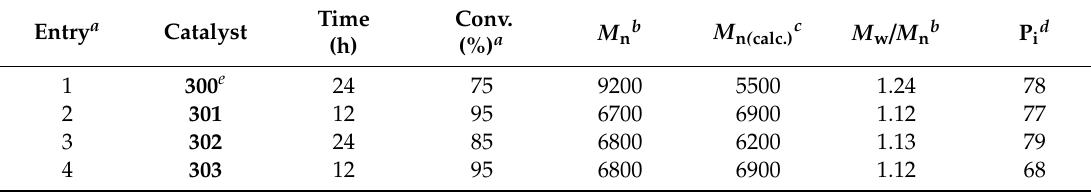
Figure 44. Unsymmetrical- and symmetric Al-salphen complexes [128]. Table 11. ROP of rac -lactide catalyzed by 300–303 [128].